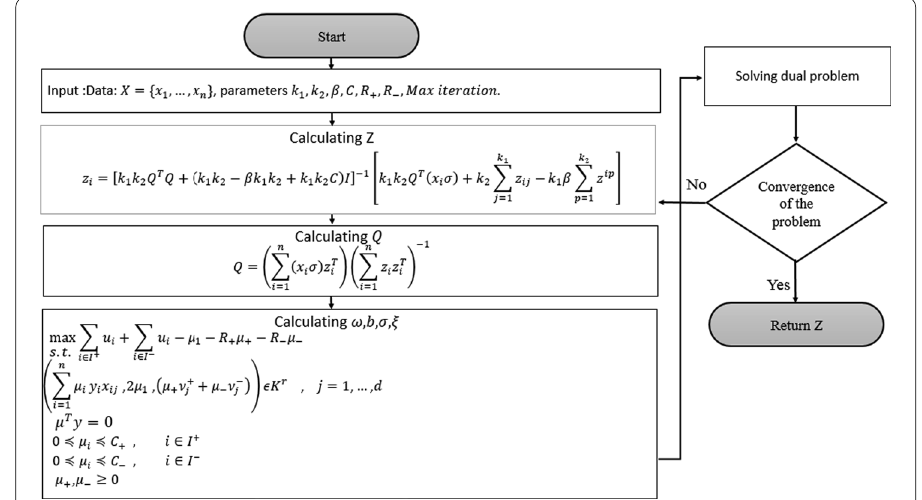
Fig. 1 The flowchart of the proposed